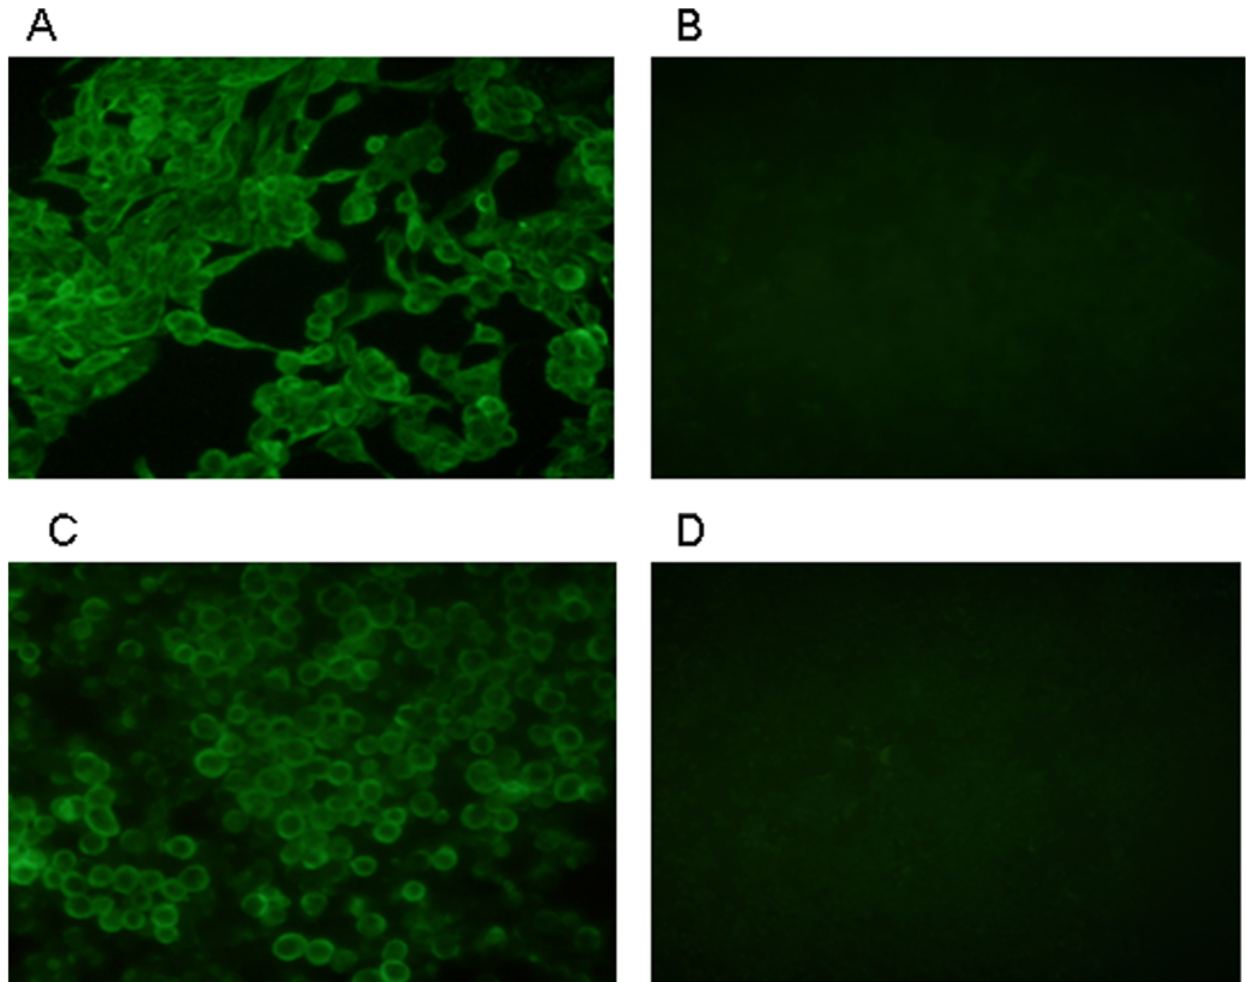
Figure 1. Monoclonal antibody characterization by immunofluorescence assay. Indirect immunofluorescence assay with cells infected with H5N1 virus or recombinant baculovirus expressing H5 HA. Infected cells were fixed and stained with mAb 5F8 and FITC-conjugated goat anti-mouse immunoglobulin. MDCK cells infected with A/Indonesia/CDC594/06 fixed at 12 h post-infection were stained with 5F8 (A); Sf9 insect cells infected with recombinant baculovirus expressing H5 HA1 were stained with 5F8 (B); mAb 5F8 did not bind to MDCK cells infected with A/common iora/ Indonesia/F89/11/95 (H7N1) (C); and also failed to bind to Sf-9 cells infected with wt baculovirus (D).